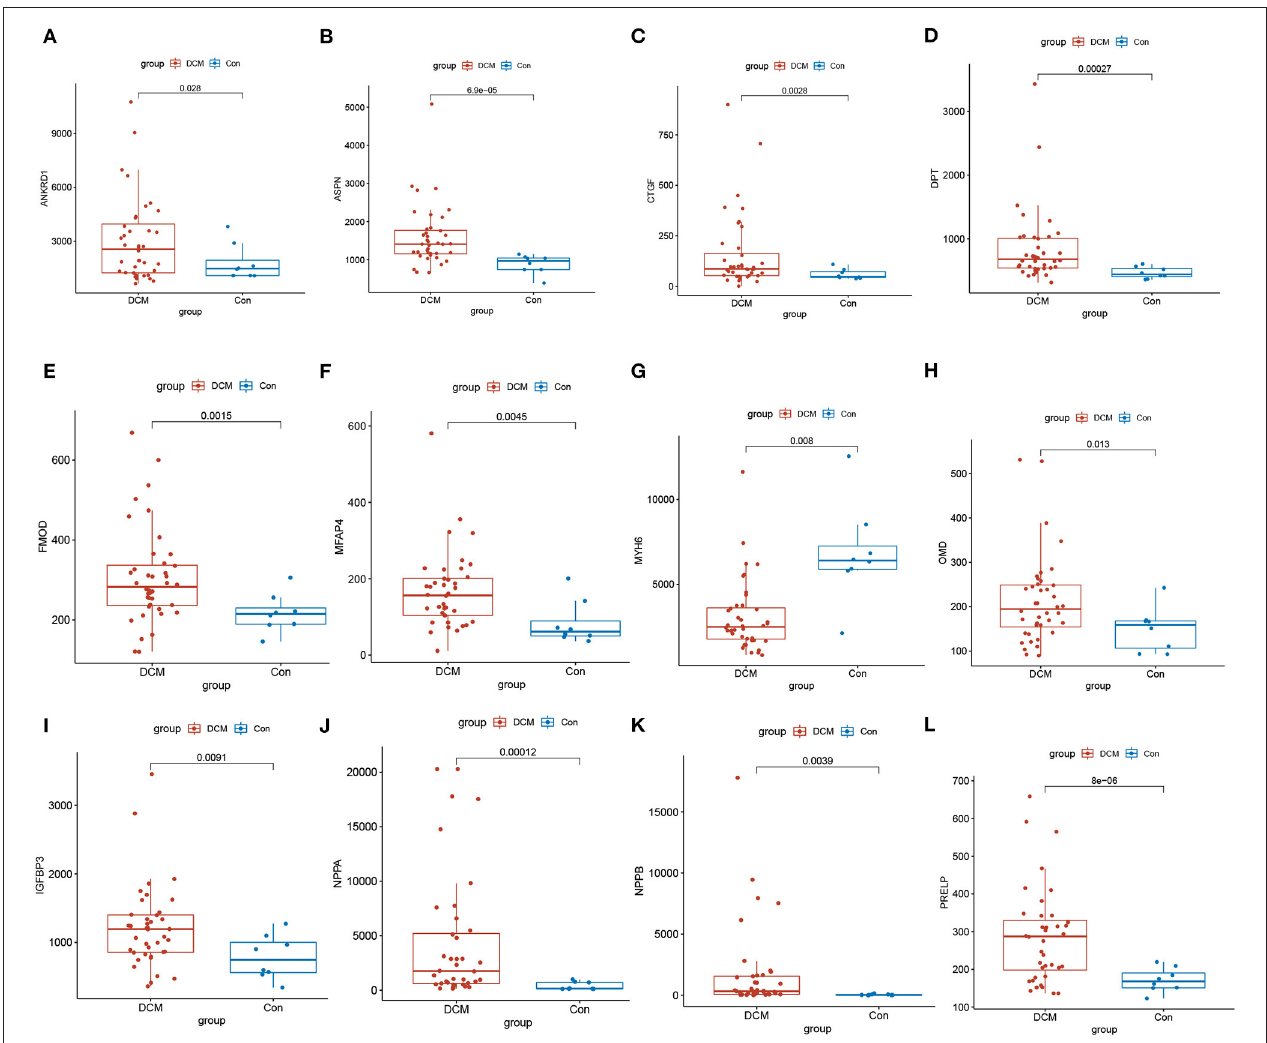
FIGURE 5 | Validation of top 25 genes with the highest degree of connectivity in GSE17800. The expression of genes (A) ANKRD1, (B) ASPN, (C) CTGF, (D) DPT, (E) FMOD1, (F) MFAP4, (H) OMD, (I) IGFBP3, (J) NPPA, (K) NPPB, (L) PRELP significantly upregulated, and (G) MYH6 significantly down regulated in the DCM in comparison to control group. DCM, dilated cardiomyopathy; Con, control